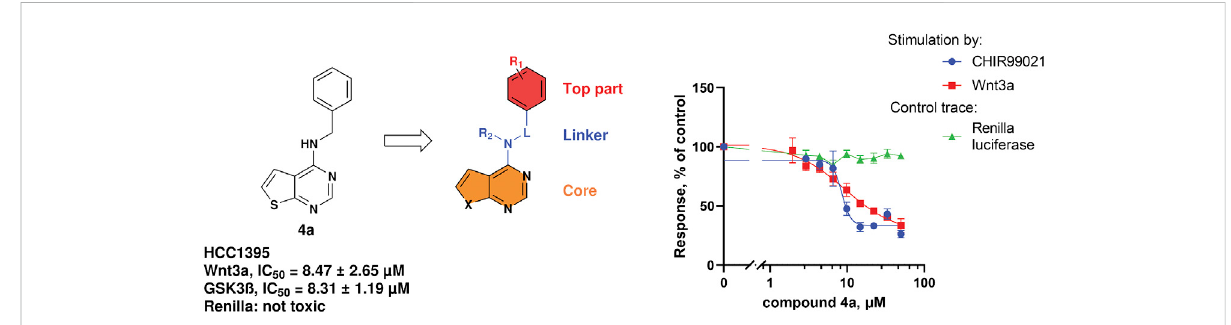
FIGURE 2 Structure of compound 4a , area of exploration for library synthesis, and concentration-dependent inhibition of the TopFlash readout.